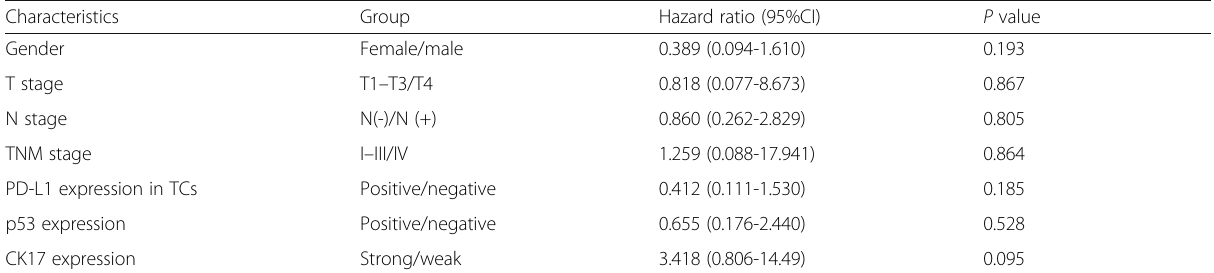
Table 2 Prognostic factors for disease-specific survival of the patients with oral squamous cell carcinoma according to multivariate